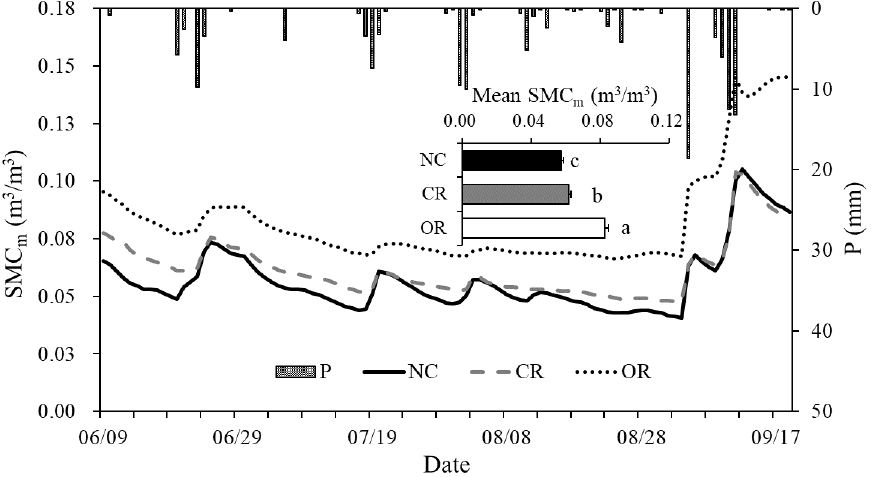
Figure 2. Dynamics of the SMC m for different treatments and precipitation during the rainy season in 2015. Different letters show a significant difference at p < 0.05 between natural condition (NC), canopy + roots (CR), and only roots (OR).